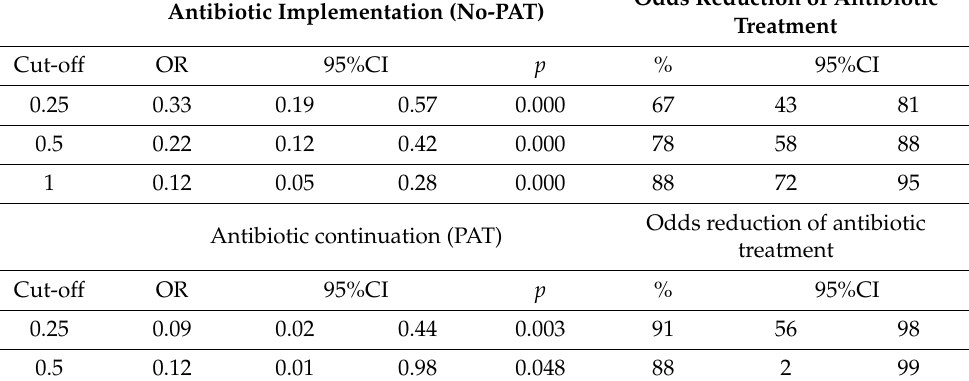
Table 4. The results of the multiple regression model for the prediction of the use of antibiotics during hospitalization; the odds ratios of antibiotic implementation in children with lower PCT values in the No-PAT group and the odds ratios of antibiotic continuation in the PAT group are shown. The corresponding percentage of the odds reduction of antibiotic treatment is